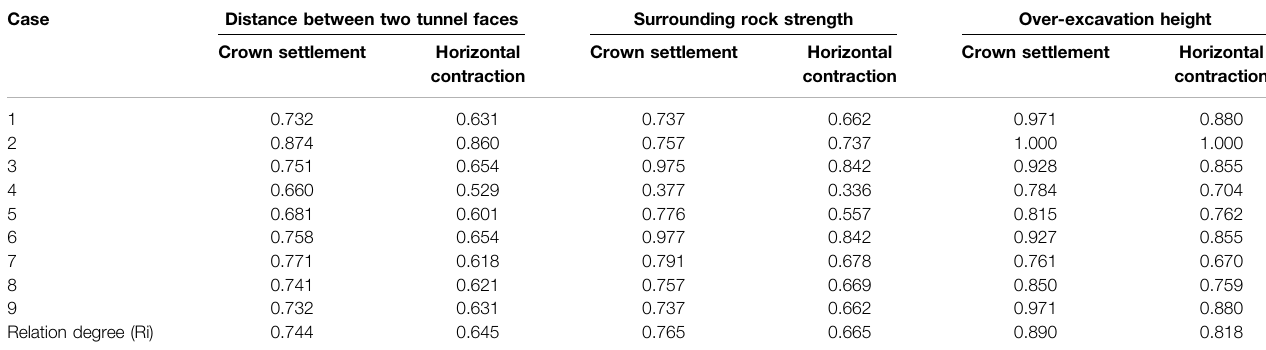
TABLE 5 | Relation coef fi cients and relation degrees of tunnel deformation.